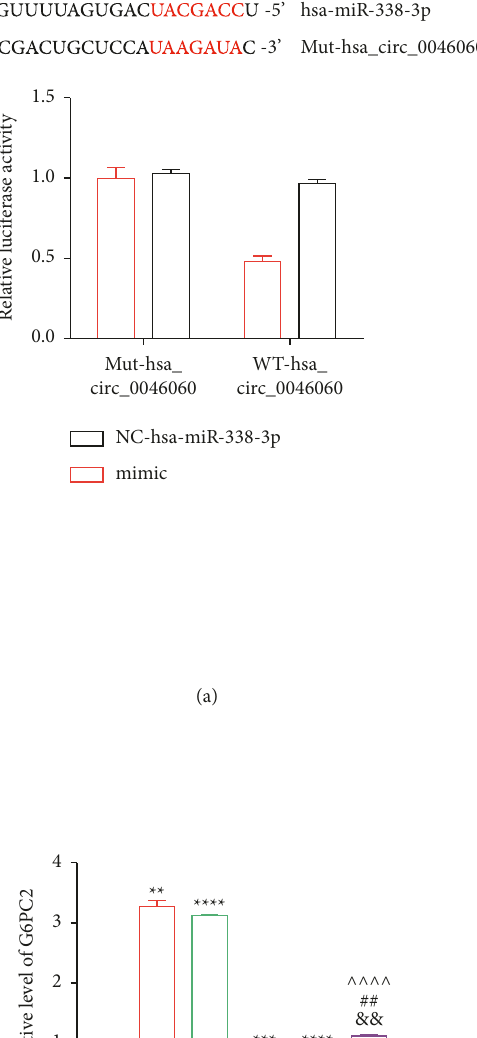
-UTR sequence of G6PC2. The relative luciferase activity was evaluate to verify the interaction between 0 . ′ ∗∗